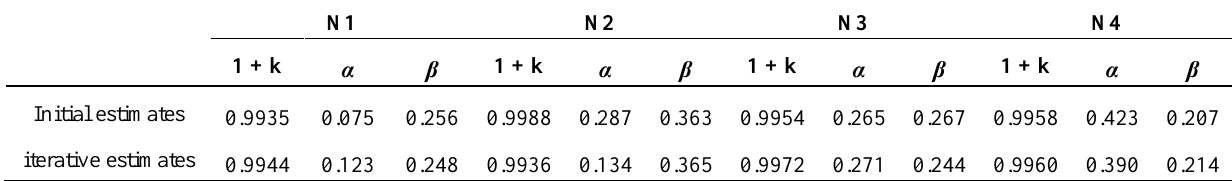
Table 3. Calibrated parameter estimates in the river trial.